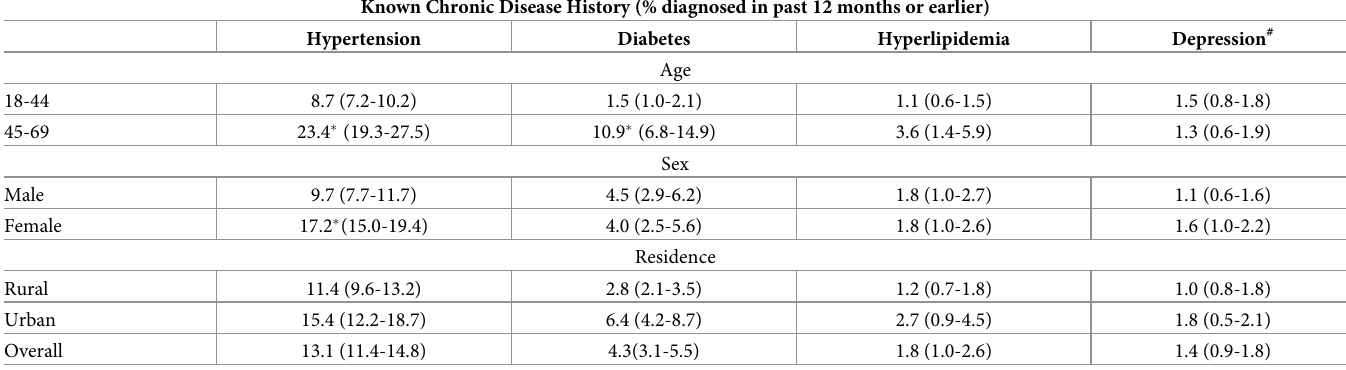
Table 5. Self-reported prevalence of NCDs in Haryana,